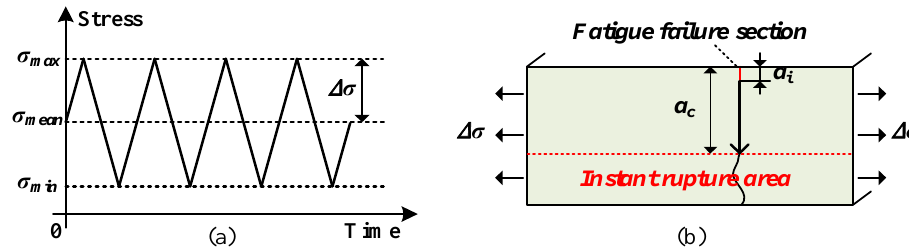
Figure 1. ( a ) Fatigue loads with constant stress amplitudes; ( b ) Simplified model of the fatigue failure process of defective homogeneous materials.